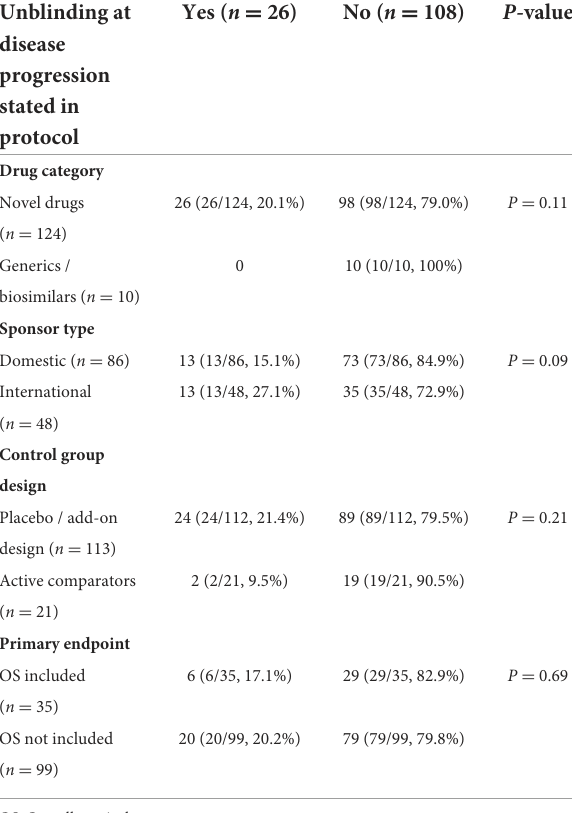
TABLE 1 The distribution of unblinding procedures by drug category, sponsor type, control group design and primary endpoint of the 134